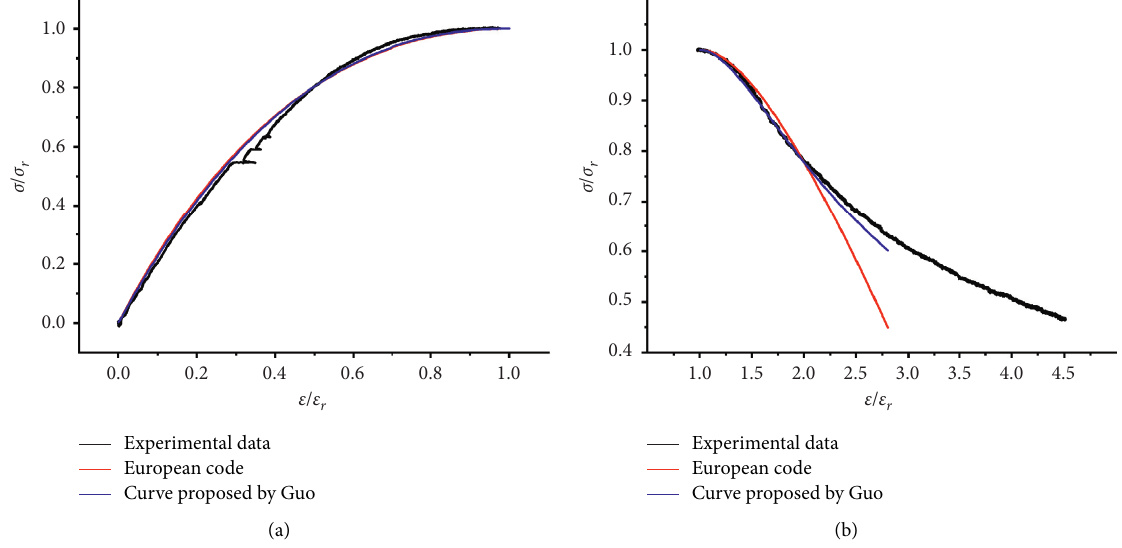
Figure 7: Comparison of constitutive curves of concrete: (a) The ascending section and (b) the descending section of the constitutive